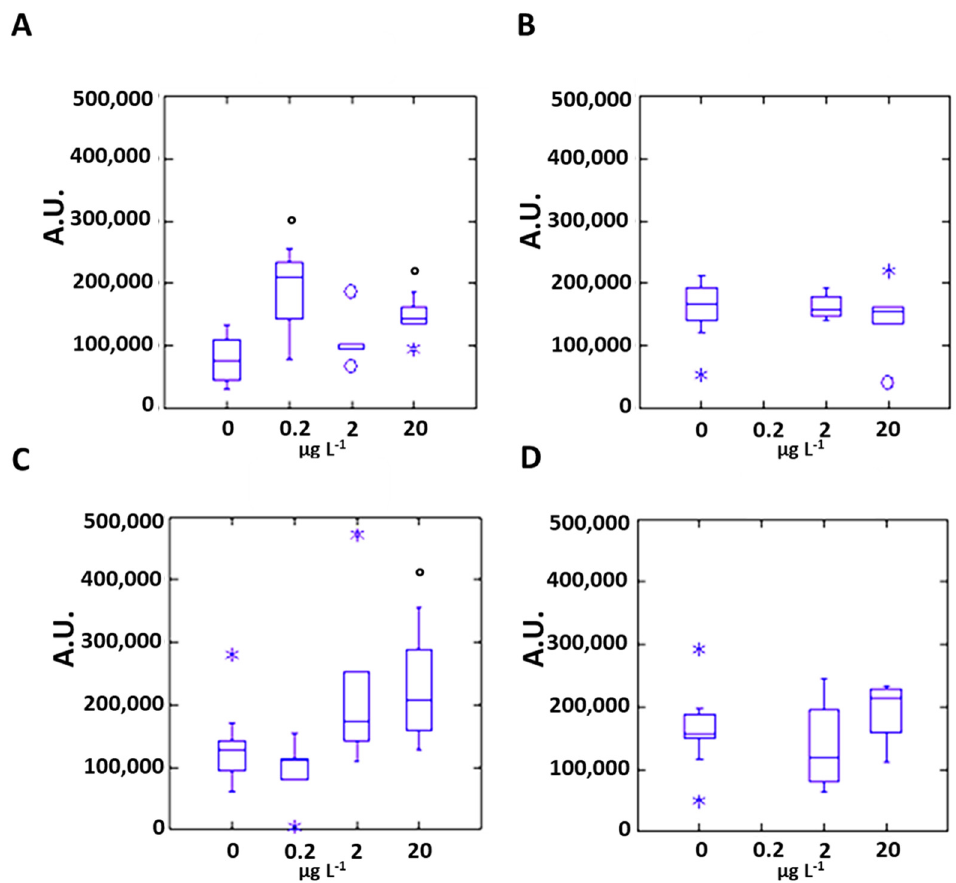
Figure 5. Effects of silver on CAT activity. Semiquantitative analysis of enzyme activity as evaluated by densitometric analysis of achromatic bands in the gel assay (boxplot). Data (arbitrary units) are only comparable within each individual panel. Values between the inner and outer fences are plotted with asterisks. Values beyond the outer fences, called far outside values, are plotted with empty circles. ( A ) Digestive gland, silver nitrate exposure; ( B ) digestive gland, silver nanoparticle exposure; ( C ) gills, silver nitrate exposure; ( D ) gills, silver nanoparticle exposure. ° statistically different from control reference (0), p < 0.05; two-sample Kruskal–Wallis, n = 40. Data for 0.2 μ g L − 1 silver nanoparticles were not available.